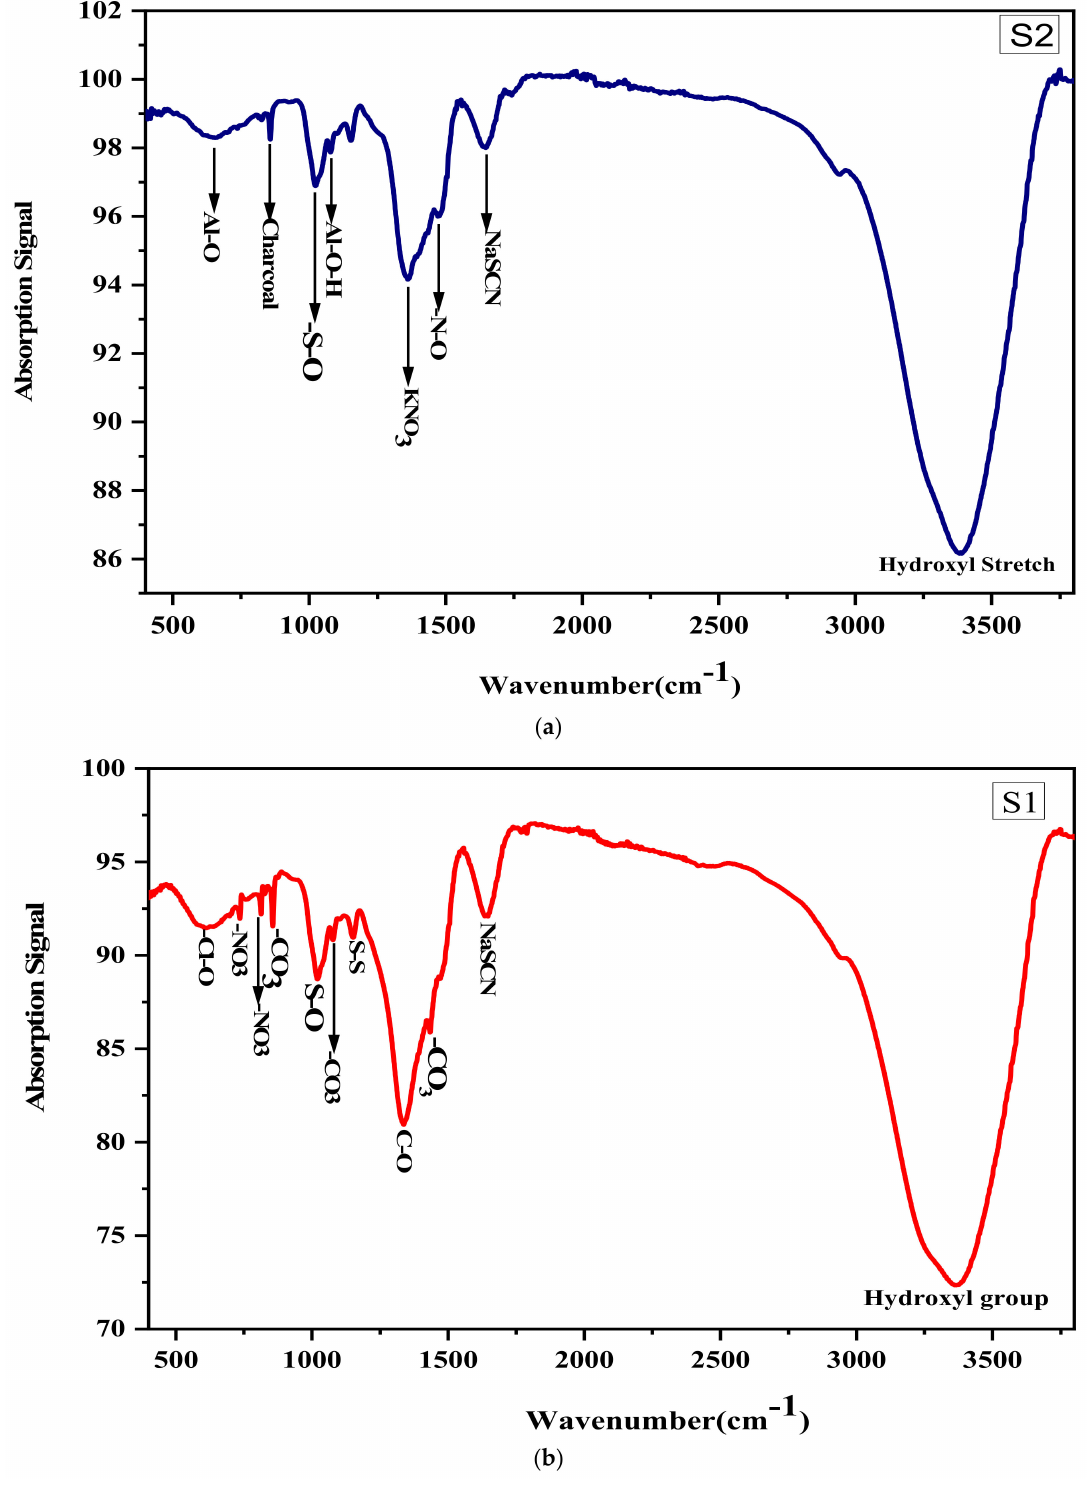
Figure 6. ( a ). Fourier Transform Infrared spectra of S2 in spectral range 500 to 3500 cm − 1 . ( b ). Fourier Transform Infrared spectra of S1 s in spectral range 500 to 3500 cm − 1